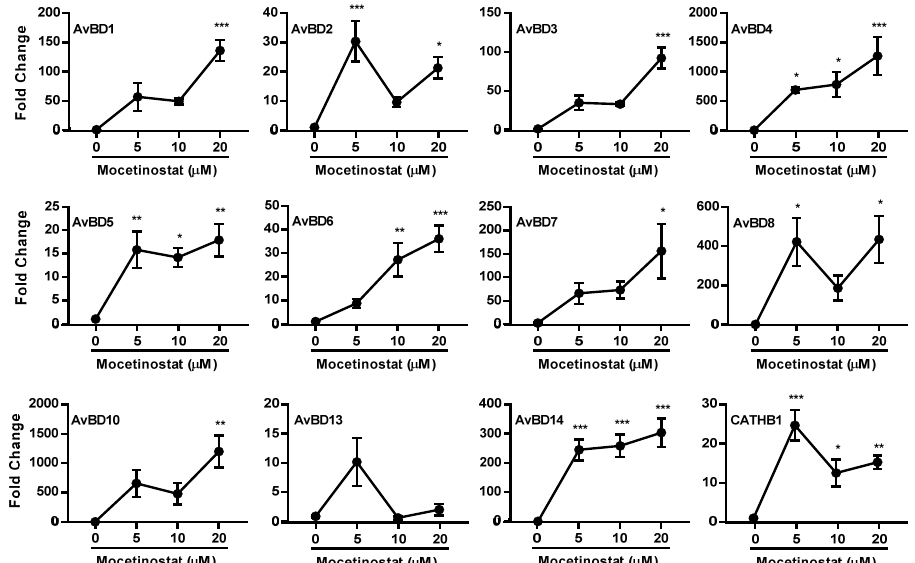
Figure 4. Induction of multiple HDP genes in chicken HTC macrophages in response to mocetinostat. HTC cells were stimulated in duplicate with 5, 10, and 20 µ M mocetinostat for 24 h. HDP gene- expression levels were evaluated using RT-qPCR. The results are means ± SEM of three independent experiments. One-way ANOVA was performed, followed by Dunnett’s test. * p < 0.05, ** p < 0.01, and *** p < 0.001 (relative to the unstimulated control).